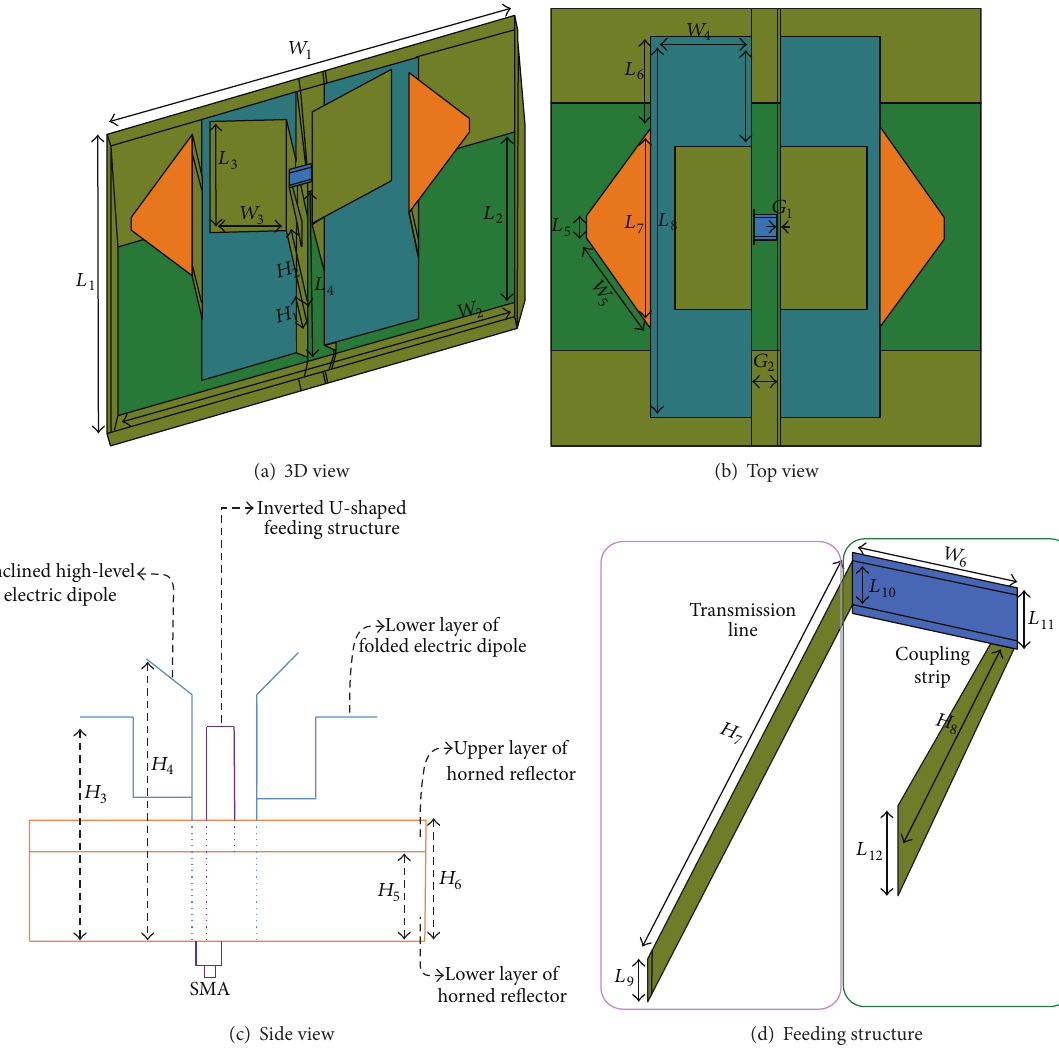
Figure 1: Geometry of the proposed